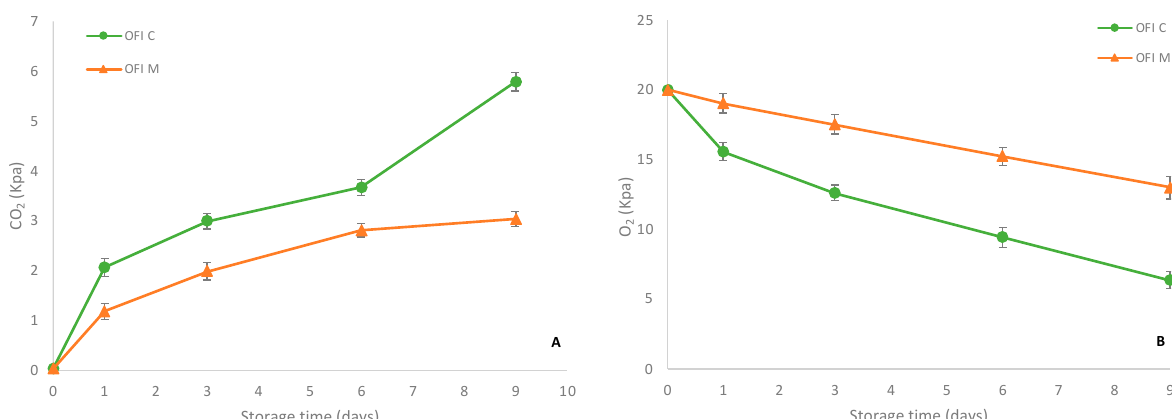
Figure 3. Concentrations of CO 2 ( A ) and O 2 ( B ) in minimally processed O. ficus-indica non-treated fruit (OFI C) and treated fruits with mucilage (OFI M) during cold storage (9 days at 5 °C). Data are the mean ± SE (bars represent standard error of the means; n = 5).